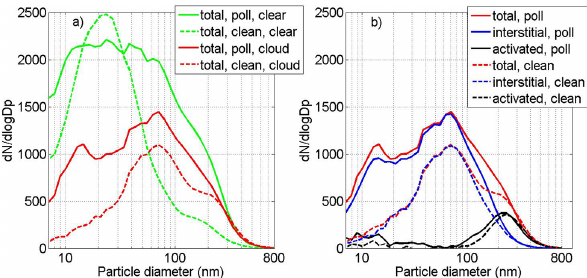
Figure 2. (a) Average total particle size distributions in both clear and cloudy conditions and (b) average total, interstitial and activated particle size distributions for polluted and clean sectors in cloudy